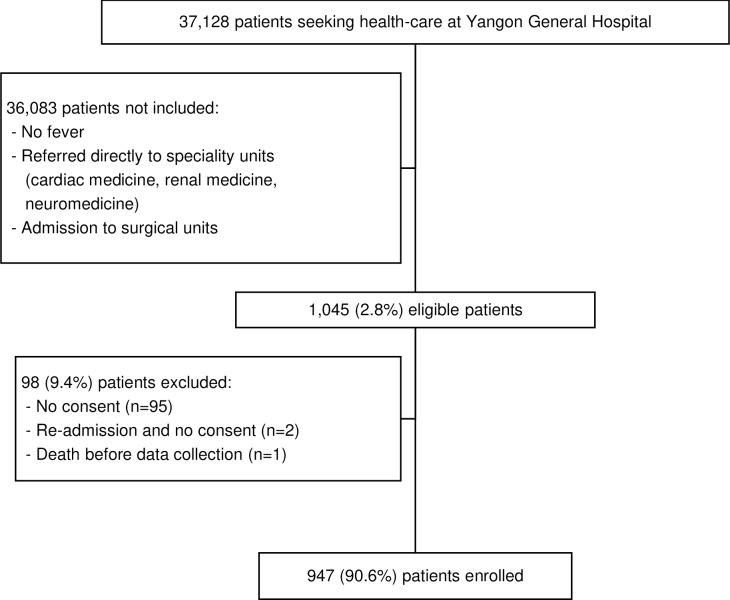
Flow diagram for enrolling febrile patients at Yangon General Hospital, 2015–2016.